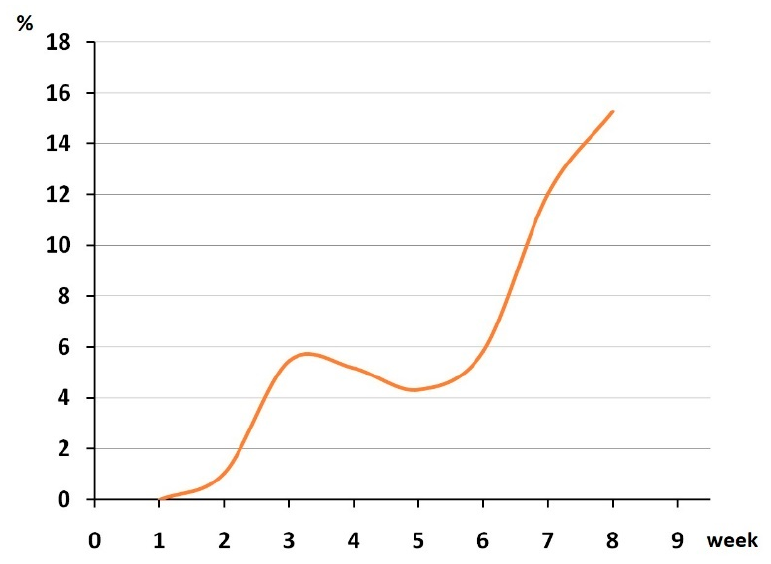
Figure 3. The number of positive cases, expressed as a percentage of the total number of tested people per